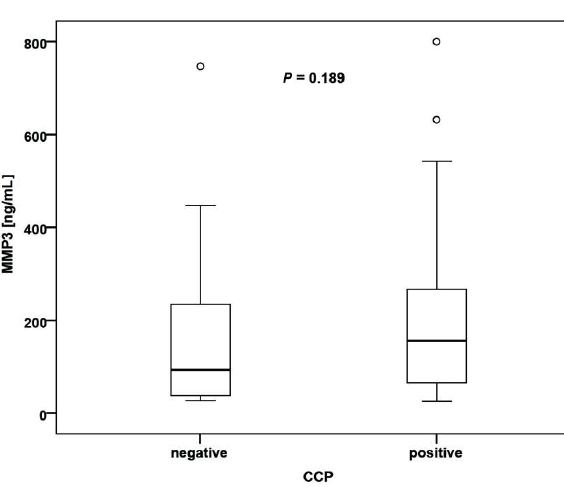
Fig. 1. Differences in serum concentration of MMP-3 between RA patients, OA patients and healthy controls. box shows the distance between the quartiles, with the median as a line, and the whiskers show minimum and maximum values of MMP3. Outliers are shown as separate points. The P -values show statisti- cal significances of differences between groups.